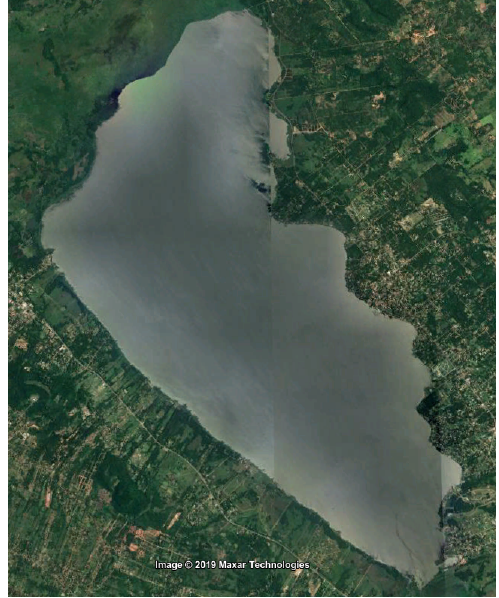
Figure 1. Satellite Image of Ypacarai